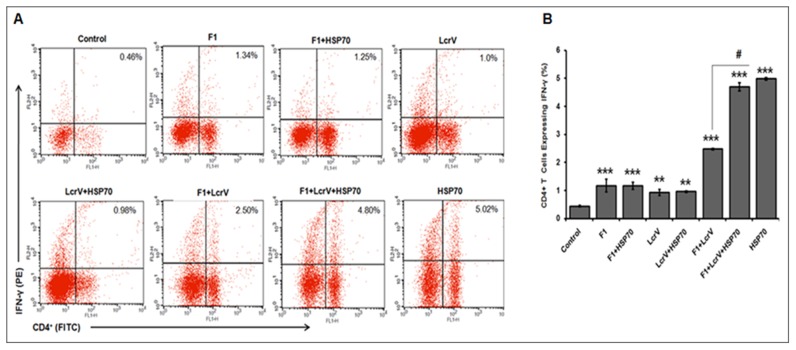
Flow cytometric analysis showing the percentage of IFN-γ producing CD4+ T cells in the spleens of immunized Balb/C mice following in vitro stimulation with specific antigens as indicated and anti-CD28 [A].Graphical representation showing the significant difference in the percentage of IFN-γ producing CD4+ T cells in the spleen of different immunized animal groups after stimulation with specific antigens in comparison to the PBS control group. Each bar represents the average of 3 mice/group ± S.D [B]. Analysis was done by one way ANOVA, All Pairwise Multiple Comparison Procedure (Fisher LSD Method). **P<0.01; ***P<0.001; #P<0.001.